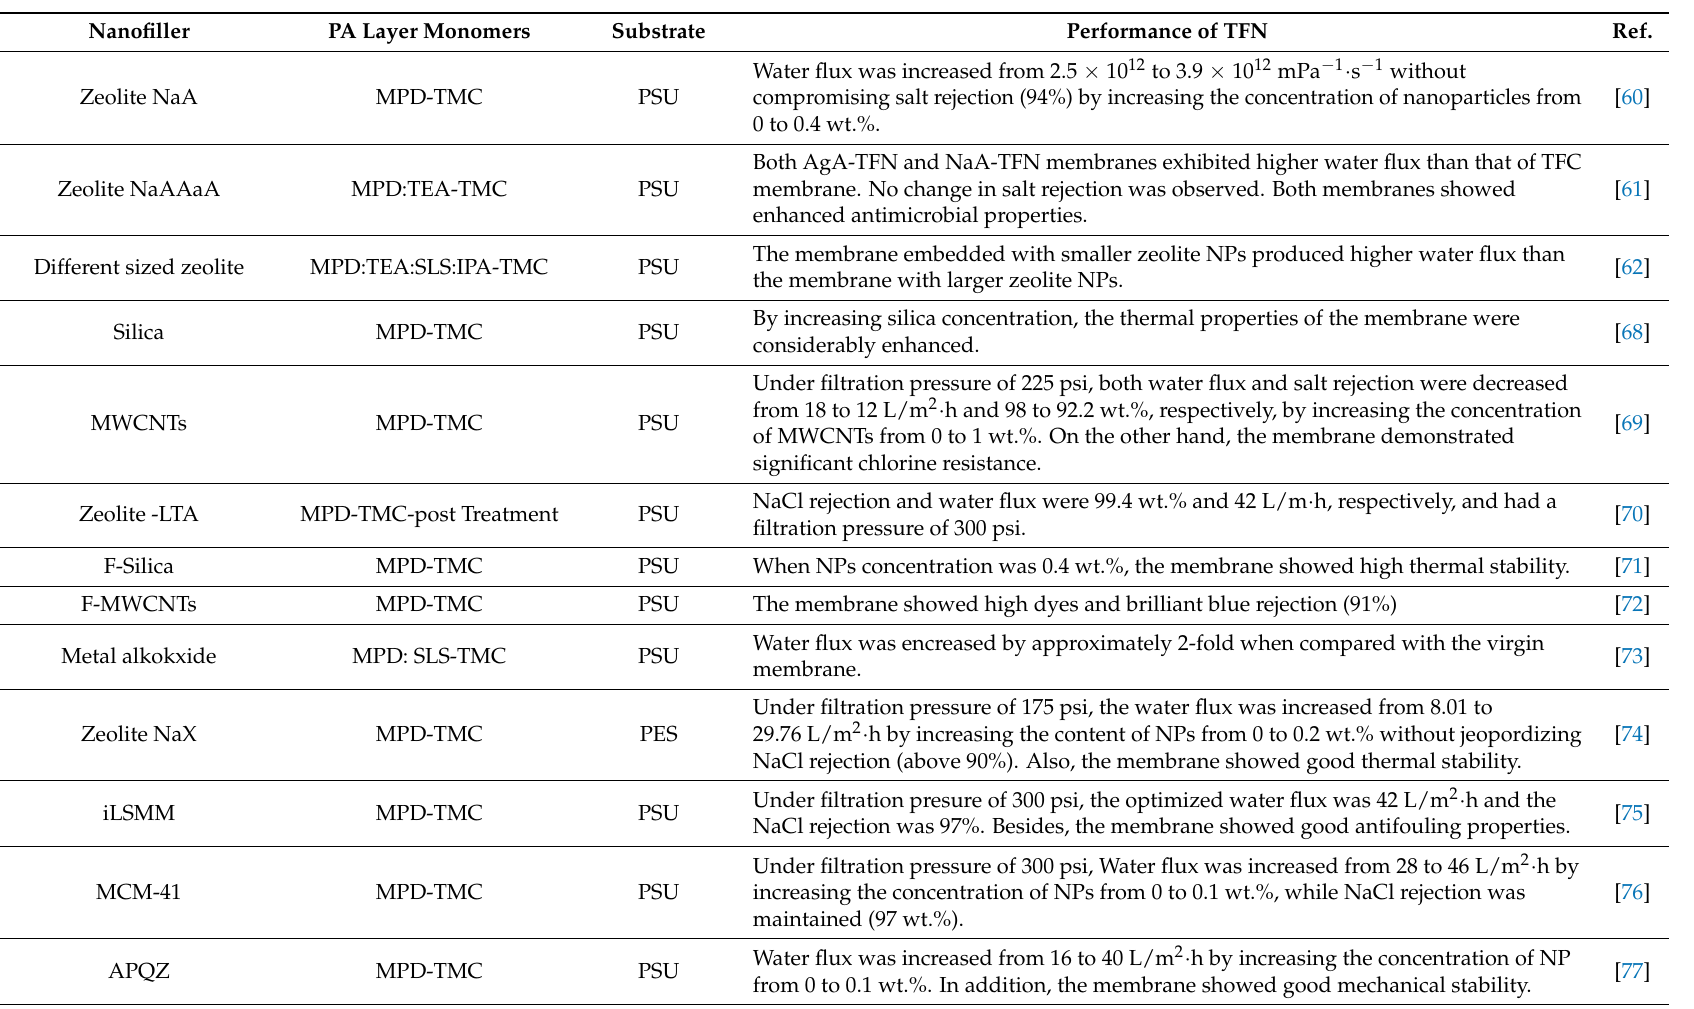
Table 2. Summary of important fillers used to modify TFC